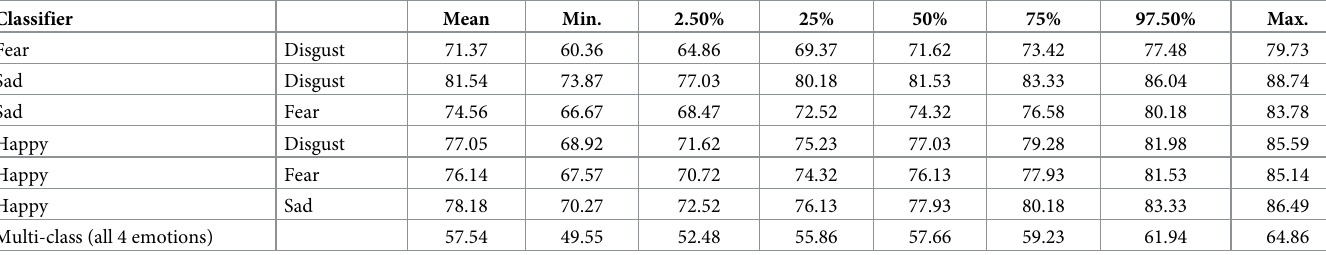
Table 1. Mean and percentiles for the distributions of out of sample generalization accuracies across 500 repetitions.